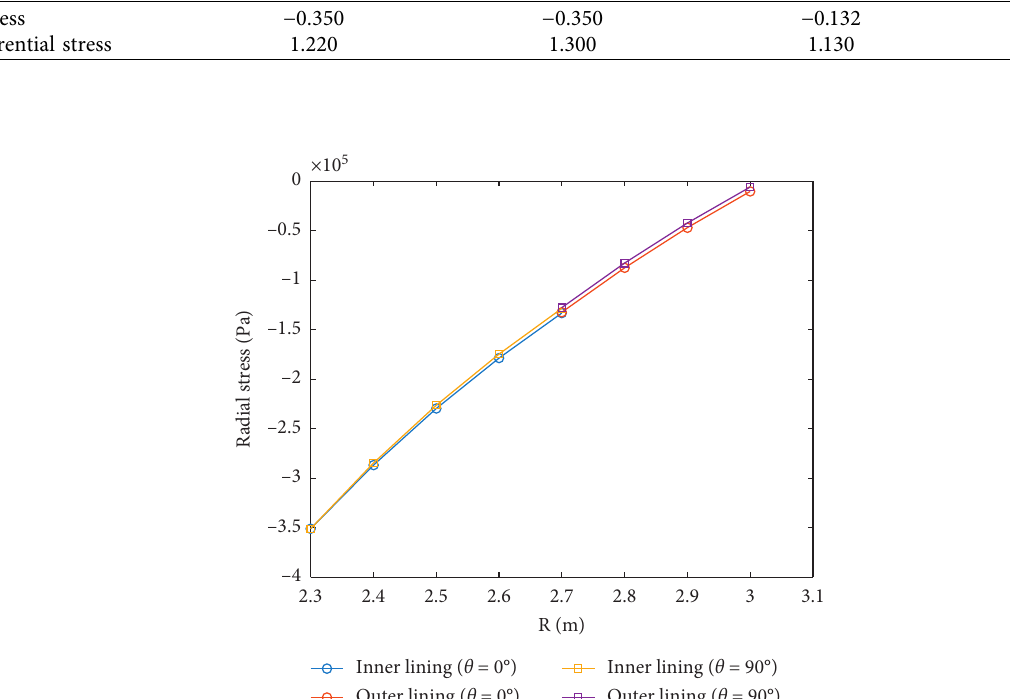
Figure 9: Distribution of radial stresses under internal pressure and in situ stress of surrounding